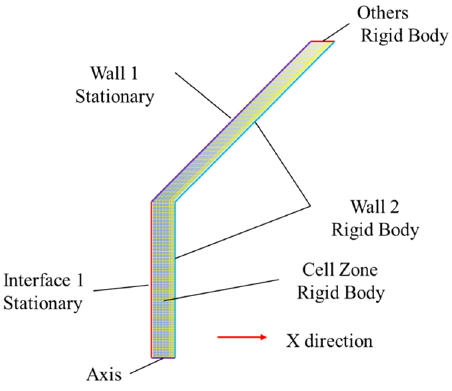
Figure 5. Moving mesh boundary.